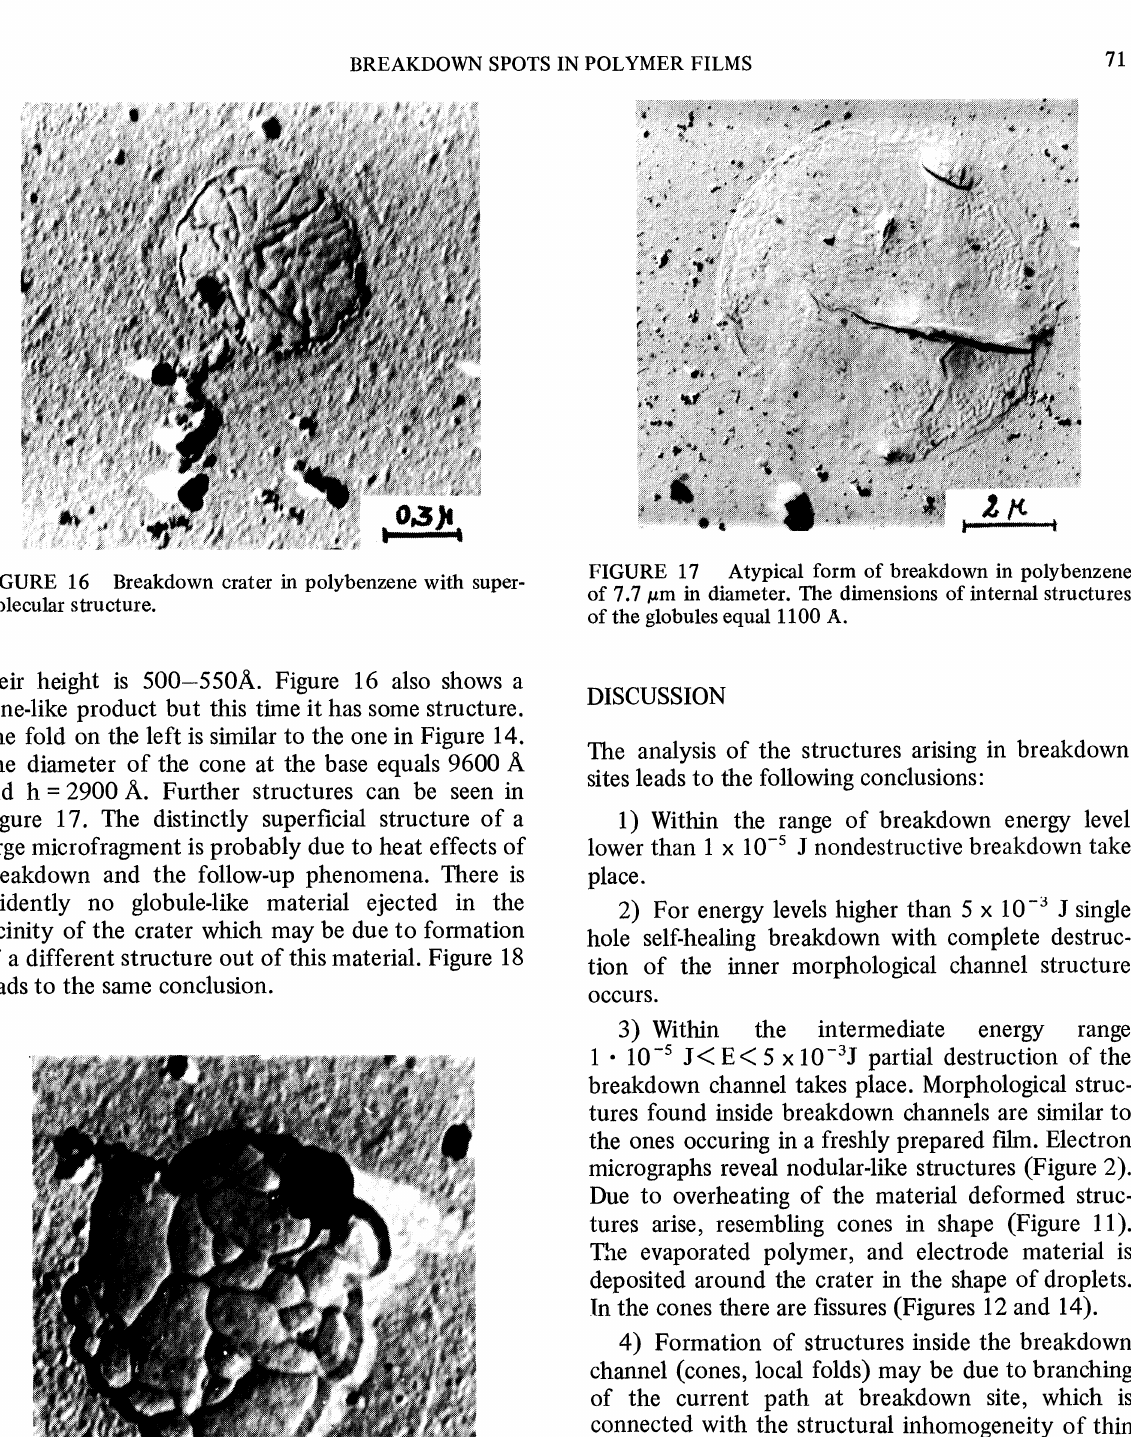
Atypical form of breakdown in polybenzene of 1.1 pm in diameter and average height of 1500